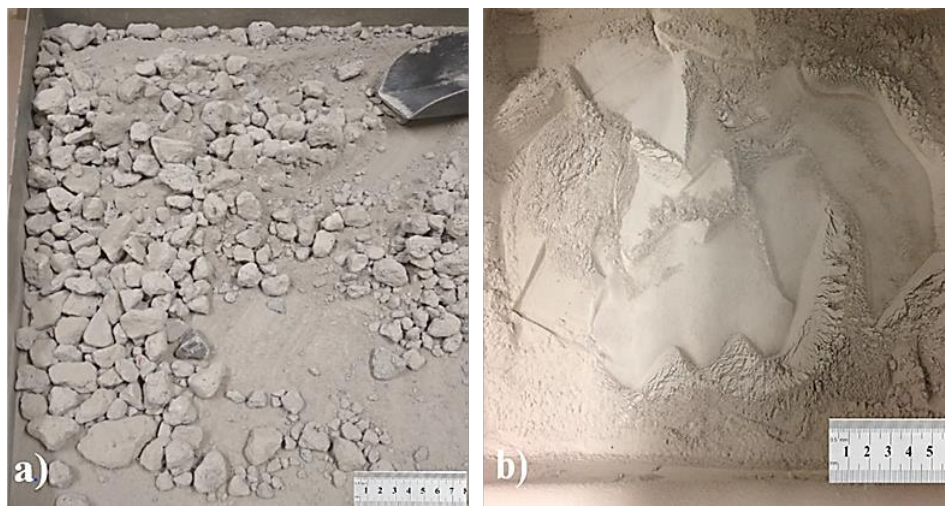
Figure 3. ( a ) Concrete rubble after thermo-mechanical treatment and ( b ) recycled fines after grinding.